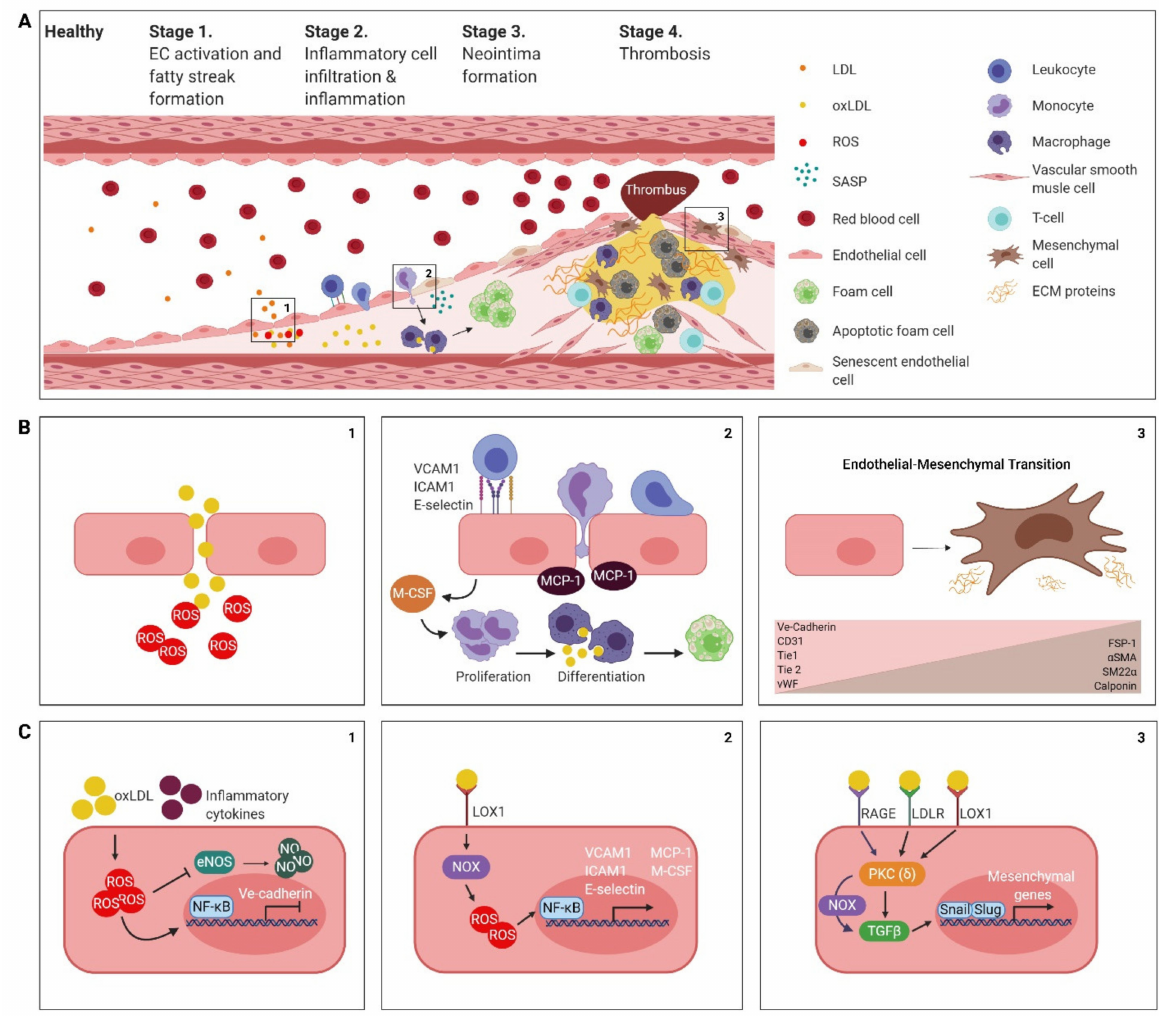
Figure 1. Endothelial cell behaviour during atherosclerotic plaque formation. ( A ) Atherosclerosis risk factors evoke endothelial cell activation, oxidative stress, and dysfunction in endothelial cells, resulting in increased vascular permeability to lipids (1), and the infiltration of inflammatory cells into the vessel wall (2). Endothelial cells (ECs) may also contribute to neointima formation by endothelial–mesenchymal transition (3). ( B ) Detailed view of intercellular interactions during (1) increased vessel permeability, (2) vessel wall inflammation and foam cell differentiation and (3) endothelial–mesenchymal transition. Loss of EC markers are represented in pink and gain of mesenchymal markers are represented in brown. ( C ) Overview of intracellular signalling in endothelial cells that links dyslipidaemia to (1) endothelial cell oxidative stress and dysfunction, (2) inflammatory activation, and (3) endothelial-mesenchymal transition. (ox)LDL: (oxidized) low density lipoprotein, ROS: reactive oxygen species, SASP: senescence-associated secretory phenotype, ECM proteins: extracellular matrix proteins, MCP-1: monocyte chemoattractant protein 1, M-CSF: macrophage colony-stimulating factor, eNOS: endothelial nitric oxide synthase, NO: nitric